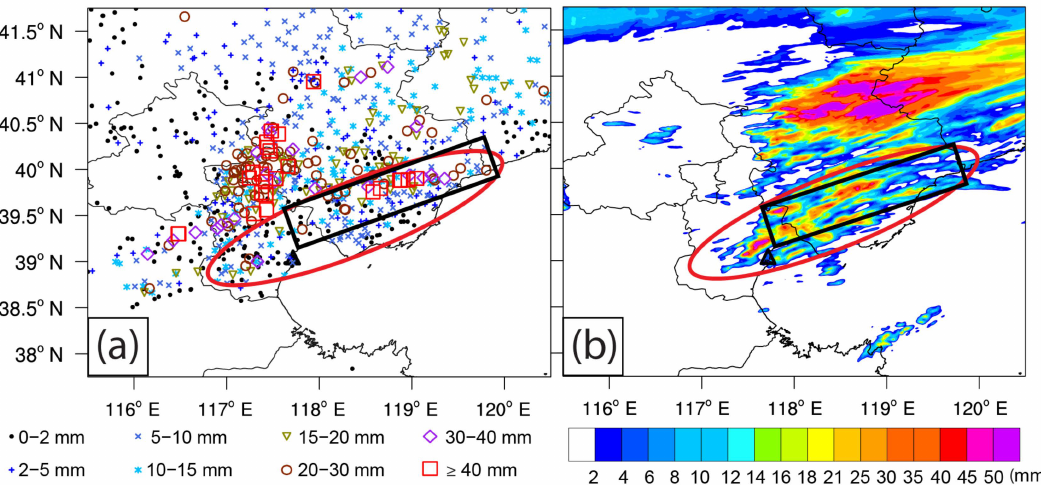
Figure 8. ( a ) Observed 6-h accumulated precipitation (colorful symbols, units: mm) observed by the ground-based automatic weather stations from 0200 to 0800 UTC on 31 July 2010; ( b ) Simulated 6-h accumulated precipitation (shading, units: mm) during the same period as ( a ). The black rectangle area indicates the merging area of the SBF and GF. The red ellipses indicate the area where precipitations were generated by the convections which were initiated and (or) intensified due to the merger of the SBF and